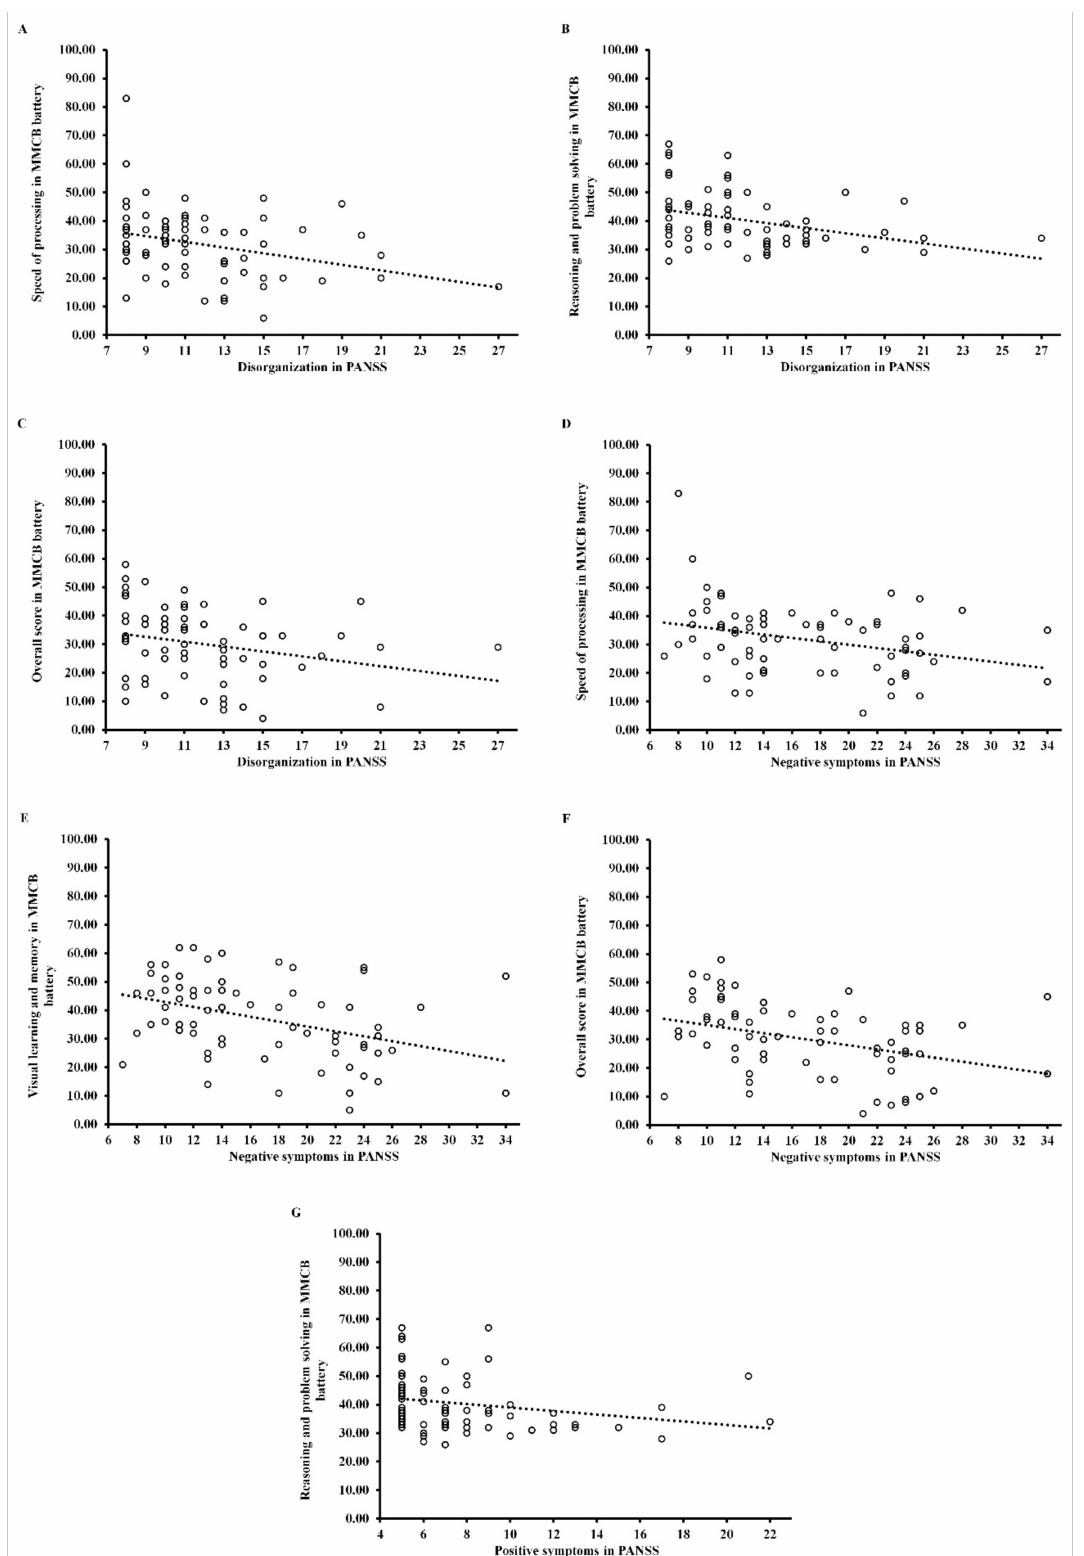
Figure 3. Scattergram for the relationship between psychopathological dimensions assessed by PANSS (( A – C ) for disorganization, ( D – F ) for negative symptoms, and ( G ) for positive symptoms) and cognitive domains measured by MMCB in Chronic Schizophrenia Patients (CS). MMCB = MATRICS Consensus Cognitive